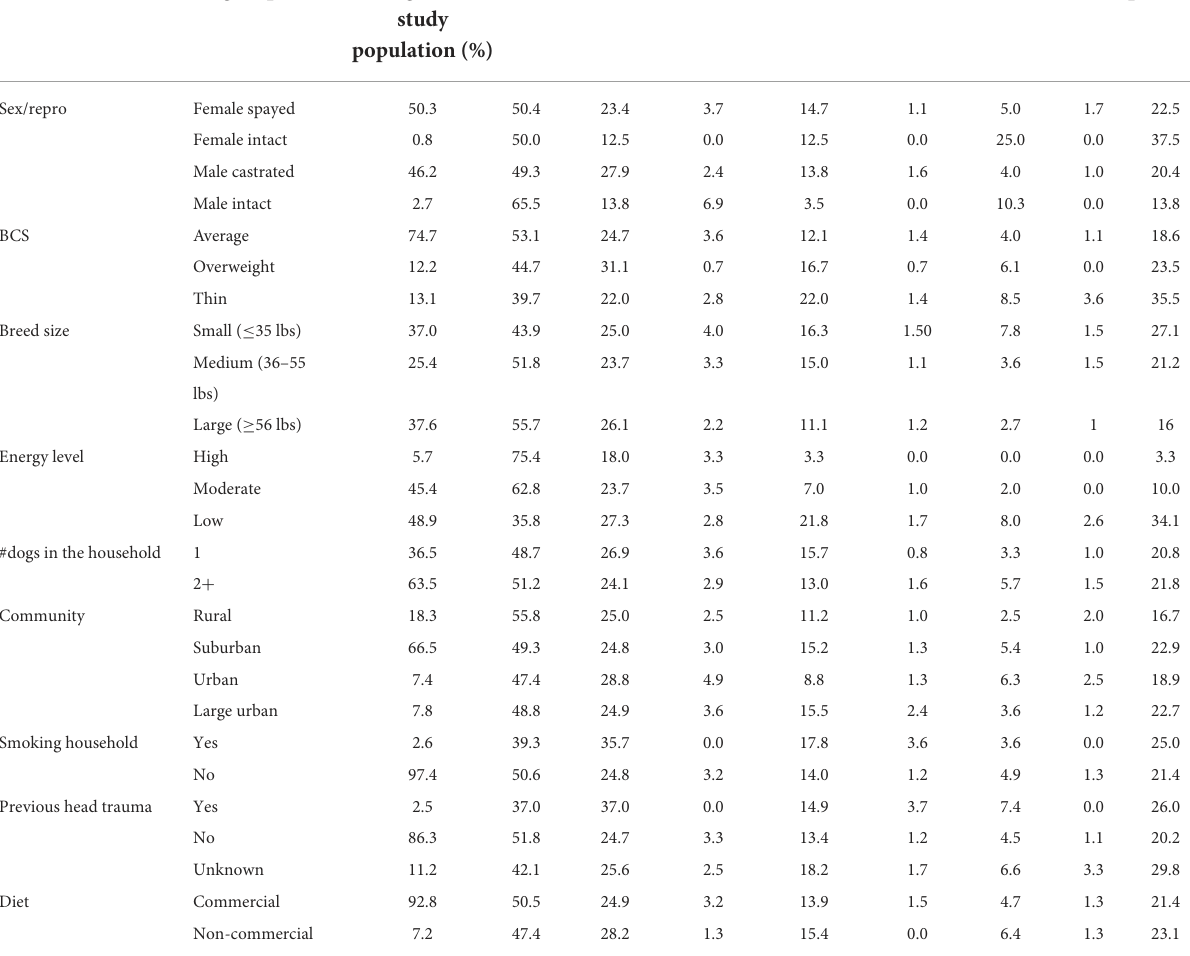
TABLE 2 The distribution of risk factors across all study groups. Distribution across all groups